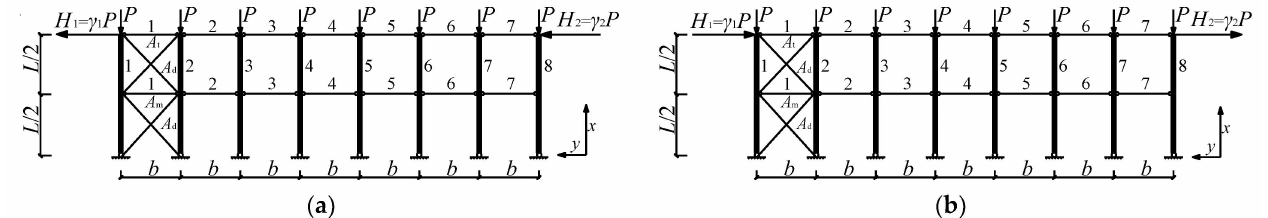
Figure 3. Analytical models of column-braced systems under horizontal and vertical loads. ( a ) The horizontal loads to the left; ( b ) The horizontal loads to the right.